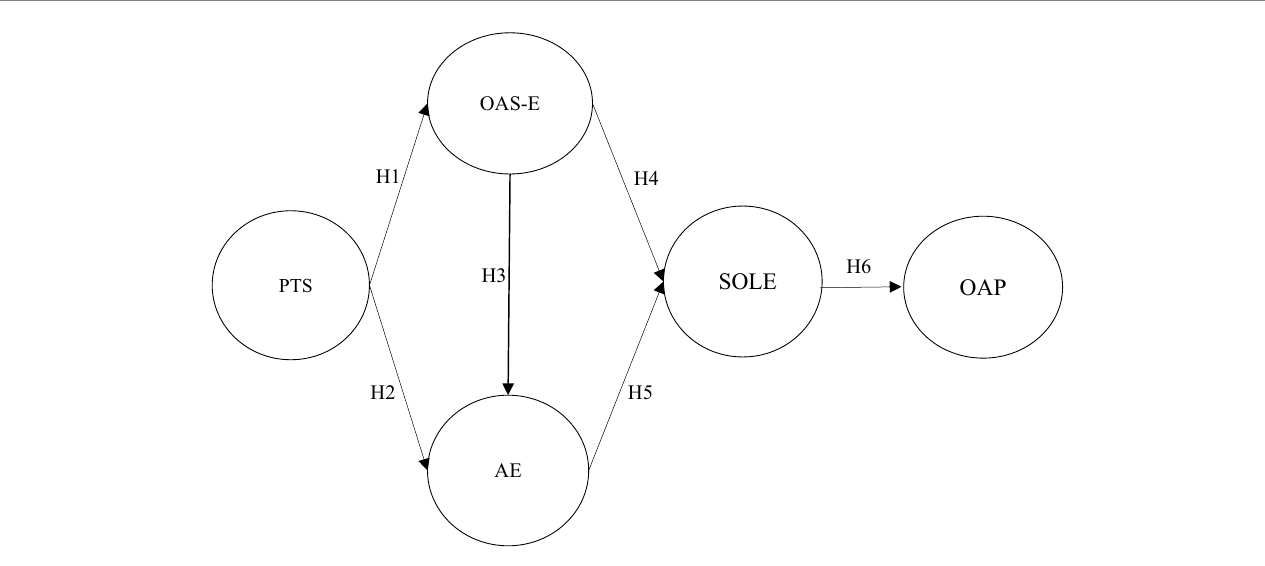
FIGURE 1 Research model. Perceived teacher support (PTS), online academic self-efficacy (OAS-E), online academic emotions (OAE), sustainable online learning engagement (SOLE), and online academic persistence